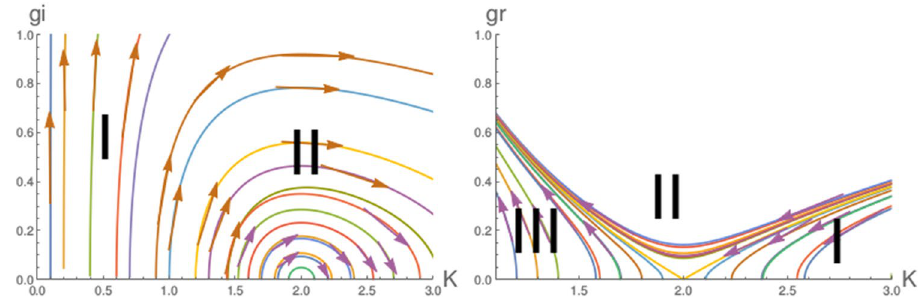
Figure 7. These figures show the RG flow lines for the exact solutions (Eqs. 11, 12) for the coupling g i (left figure) and g r (right figure). The regions mark by I and II for the left figures are respectively for the superfluid and TLL phase region. The regions mark by I, II and III for the right figures are respectively for the TLL, cross over phase and and strong coupling Mott insulating phase. Different colours for the RG flow lines have no extra physical